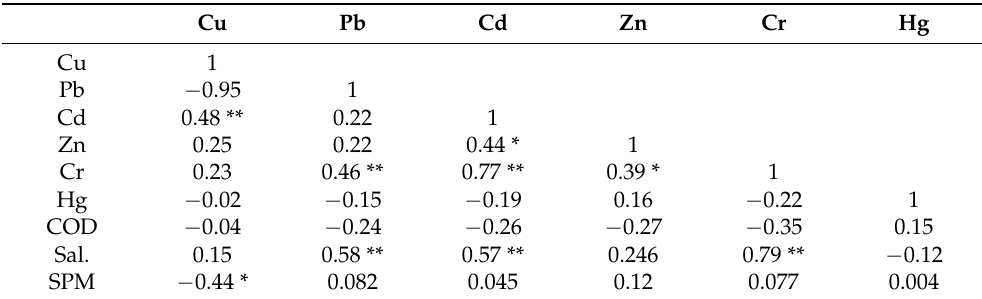
Table 1. Person correlation matrix for total heavy metal concentrations and the physicochemical parameters in seawater. Cu Pb Cd Zn Cr Hg Cu 1 Pb − 0.95 Cd 0.48 ** 0.22 Zn